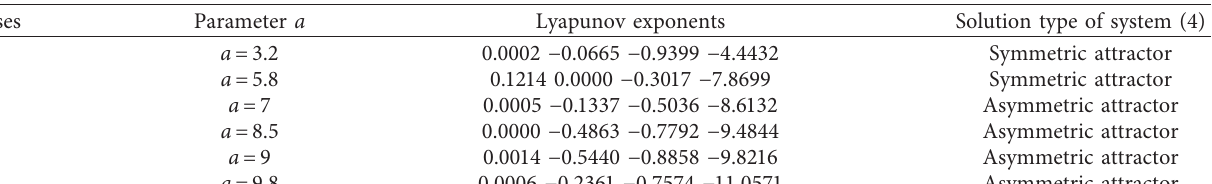
Figure 6: Various periodic oscillations in system (4) with b � 2, c � 5, d � 0.75, and k � 1 and (a) a � 3.2, (b) a � 5.8, (c) a � 7, (d) a � 8.5, (e) a � 9, and (f) a � 9.8, IC � (0.1, 0.1, 0.1, 0.1) is blue, ( − 0 1, 0.1, 0.1, 0.1) is red, and (0.1, 0.1, − 0.1, 0.1) is green. Table 1: Periodic oscillations in system (4) under different parameters of a .